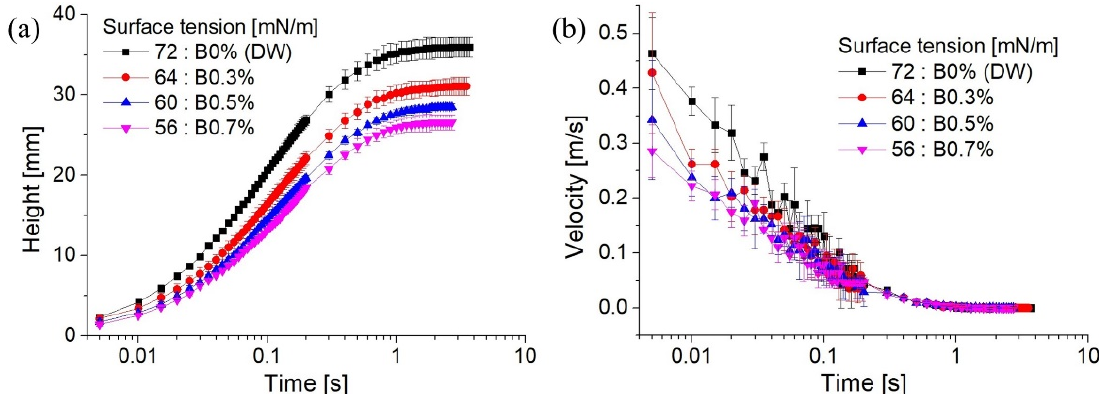
Figure 8. Effect of surface tension of liquids ( σ = 56, 60, 64, and 72 mN/m) on capillary rise dynamics at r = 0.4 mm. ( a ) height and ( b ) velocity.